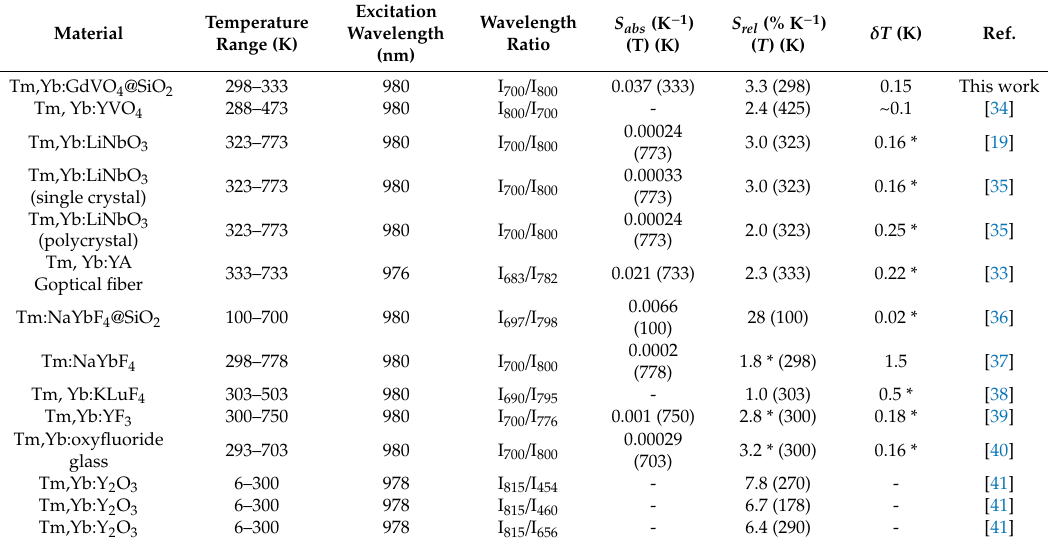
Comparison of the performance of Tm 3 + -doped systems used in luminescence nanothermometry operating totally or partially in the